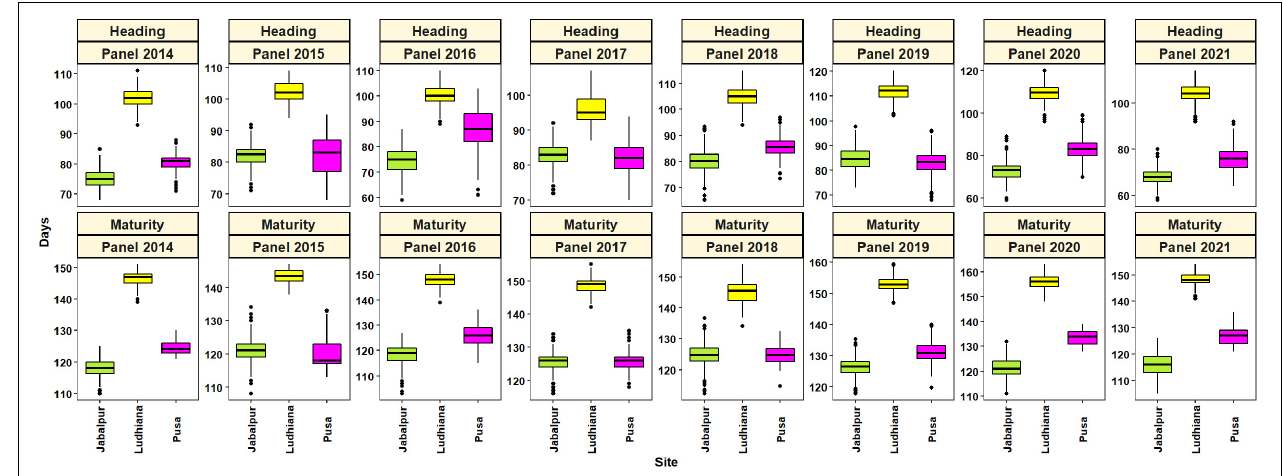
FIGURE 1 | Boxplots showing the distributions of heading and maturity in Jabalpur, Ludhiana, and Pusa in panels 2014–2021.